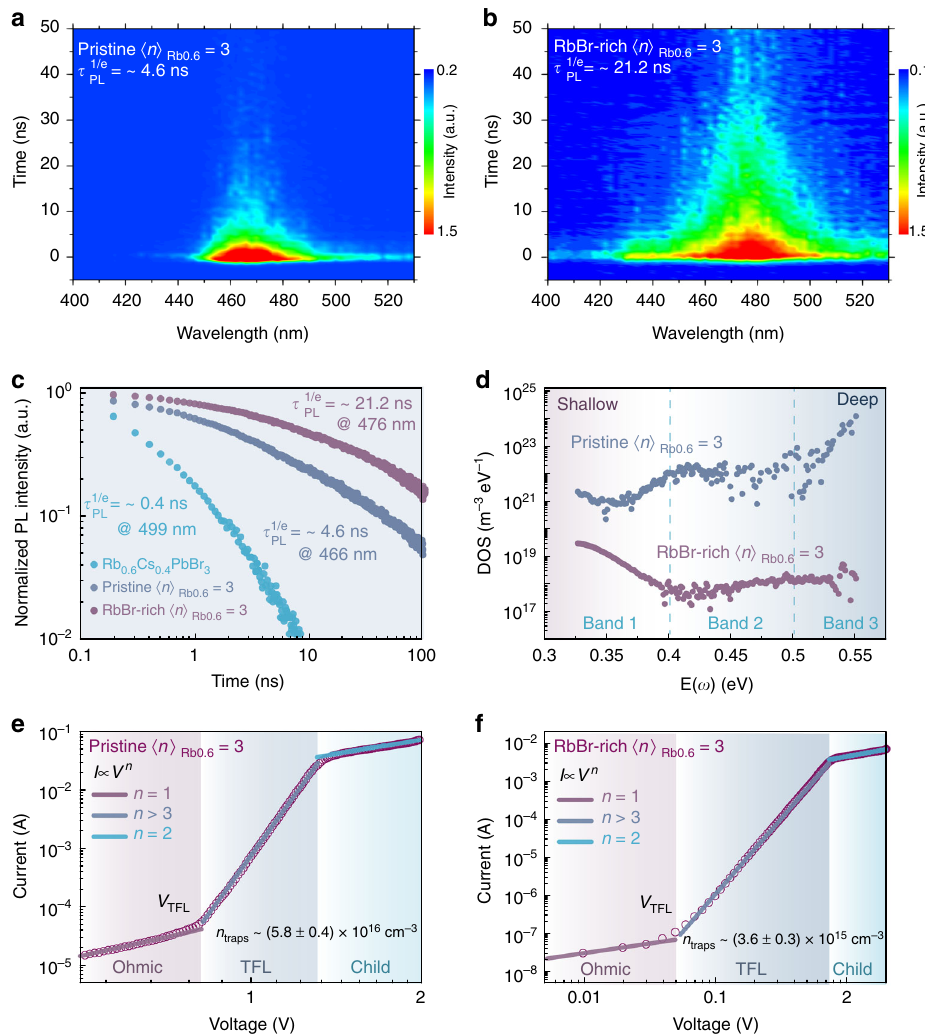
Fig. 3 Characteristics of trap densities. TPRL measurements of ( a ) pristine and ( b ) RbBr-rich 〈 n 〉 Rb0.6 = 3 fi lms. c The PL lifetime for 3D Rb 0.6 Cs 0.4 PbBr 3 , pristine, and RbBr-rich 〈 n 〉 Rb0.6 = 3 fi lms. d Trap density of states ( t DOS) for pristine and RbBr-rich 〈 n 〉 Rb0.6 = 3 perovskite in TAS analysis. Current – voltage ( J – V ) response of ( e ) pristine and ( f ) RbBr-rich 〈 n 〉 Rb0.6 = 3 fi lms in SCLC